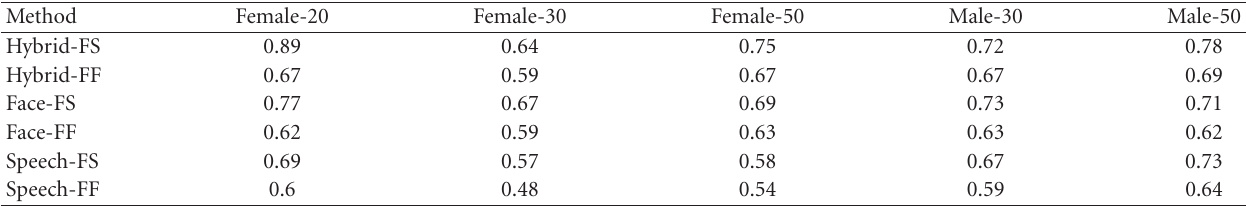
Table 2: Comparisons using AUC values in 5 groups (Hybrid: combining face and speech data, FF: using full features, FS: using feature selection).